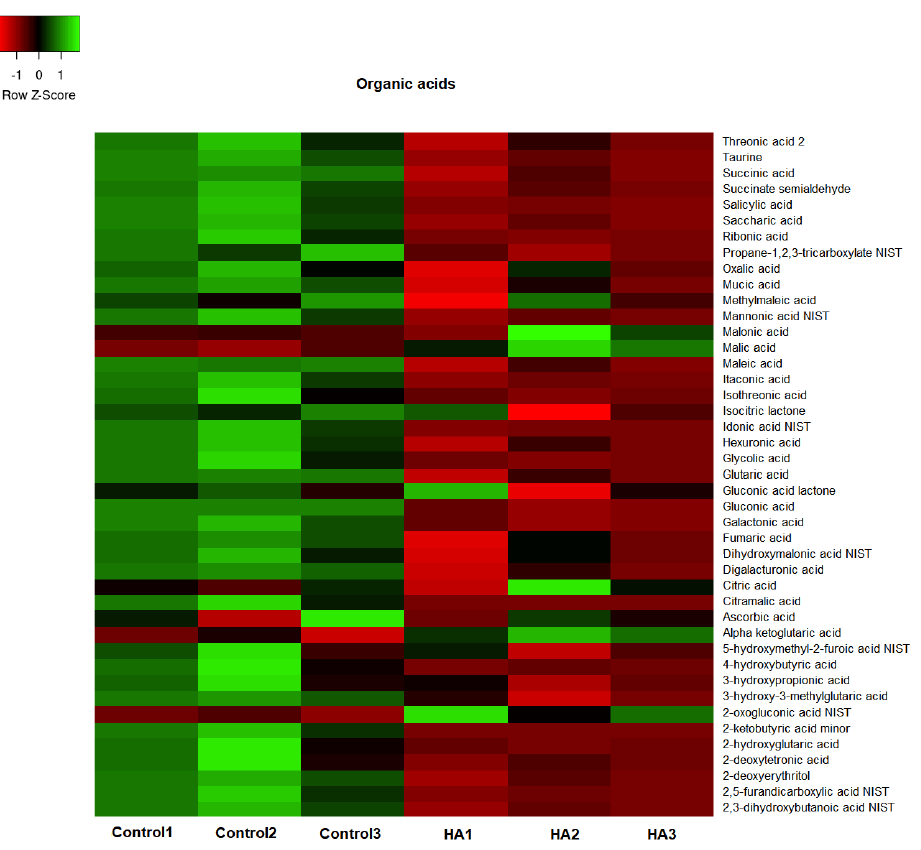
Figure 5. The concentration map of organic acids (heat map of scaled concentrations) by plants treated with humic acids (HA) or not (Control).